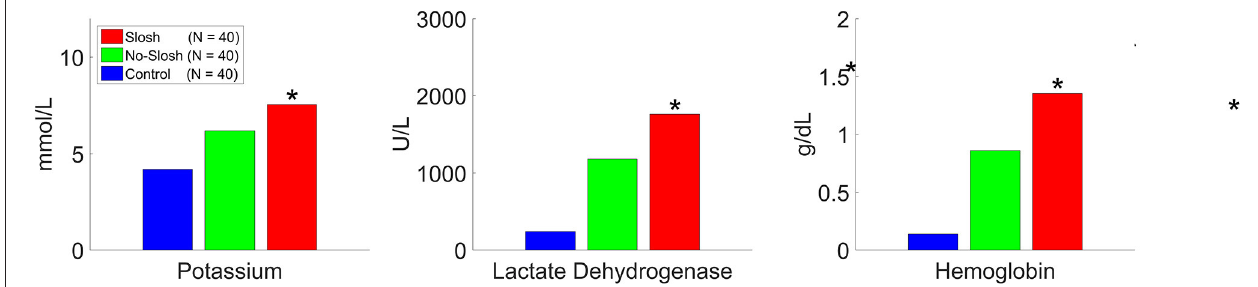
FIGURE 8 | Potassium, lactate dehydrogenase, and potassium levels as measured 2h following the blood blasting procedure, with BLUE representing “control”, GREEN representing “no-slosh,” and RED representing “slosh.” “*” indicates statistically significant difference.